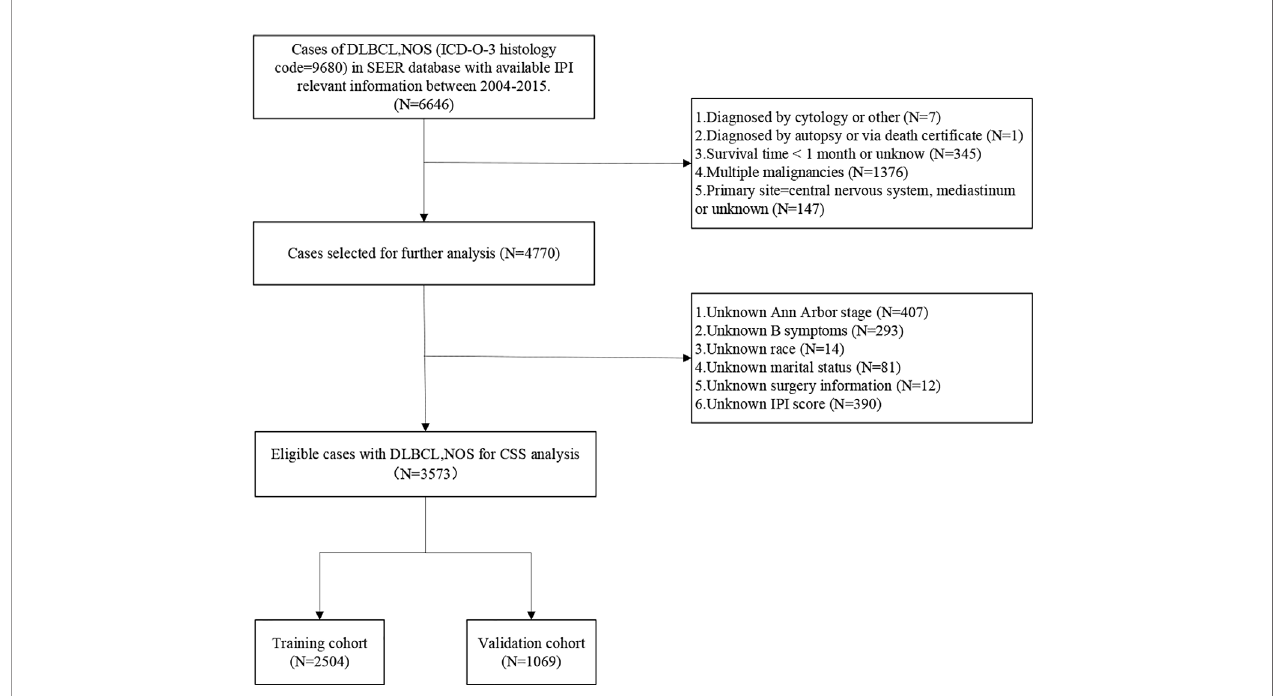
FIGURE 1 | Flow diagram describing the evaluation and selection of patients with